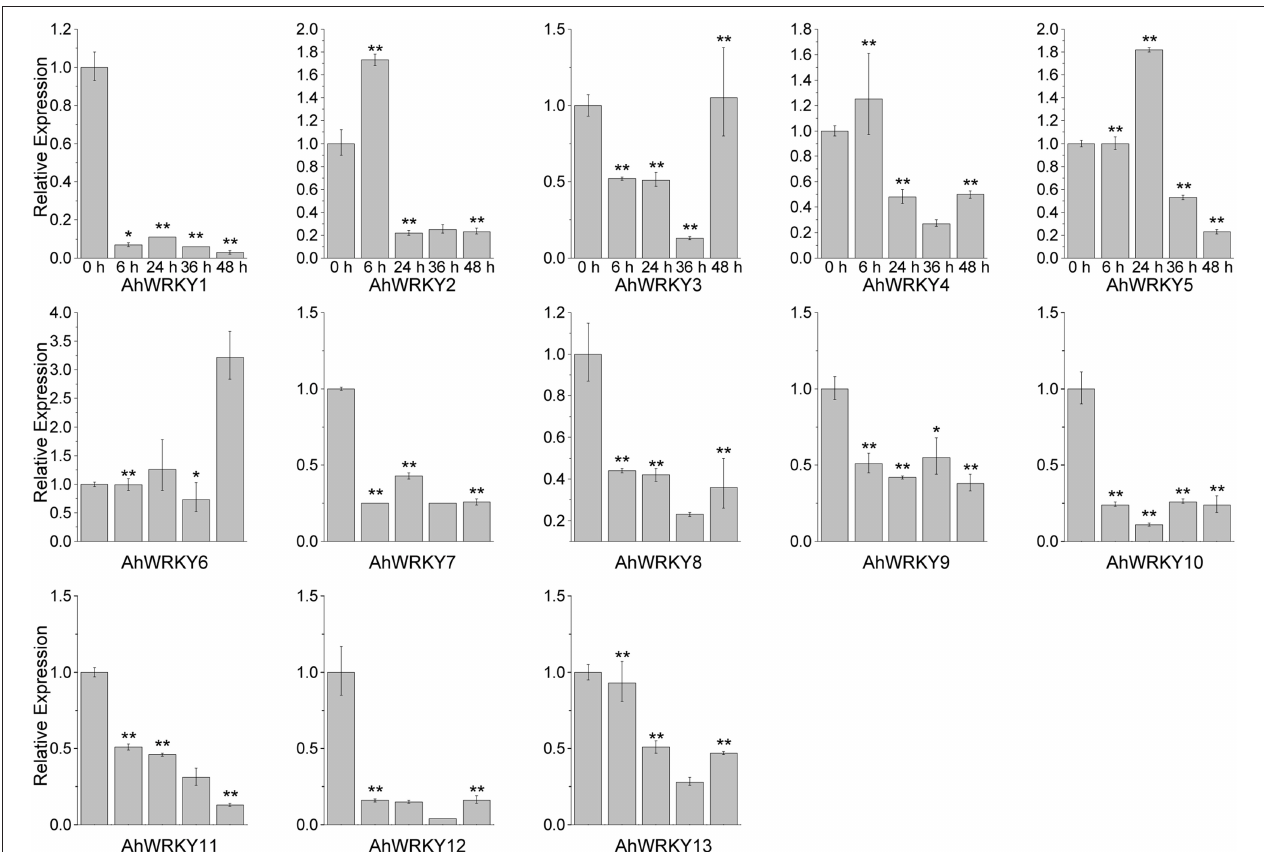
FIGURE 4 | The expression pattern of AhWRKY genes after SA treatment. The Y-axis indicates the relative expression level; X-axis (0, 6, 24, 36, and 48 h) indicated hours of SA treatment. The standard errors are plotted using vertical lines. * and ** mean significant difference at P < 0.05 and P < 0.01, respectively.